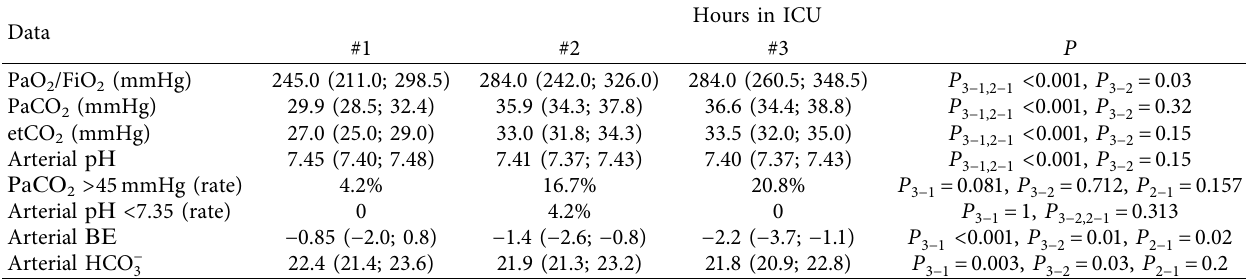
Table 5: Changes in oxygenation, elimination of CO 2 , and acid-base balance of arterial blood in patients from the control group, median (25 th ; 75 th percentile), n � 24.